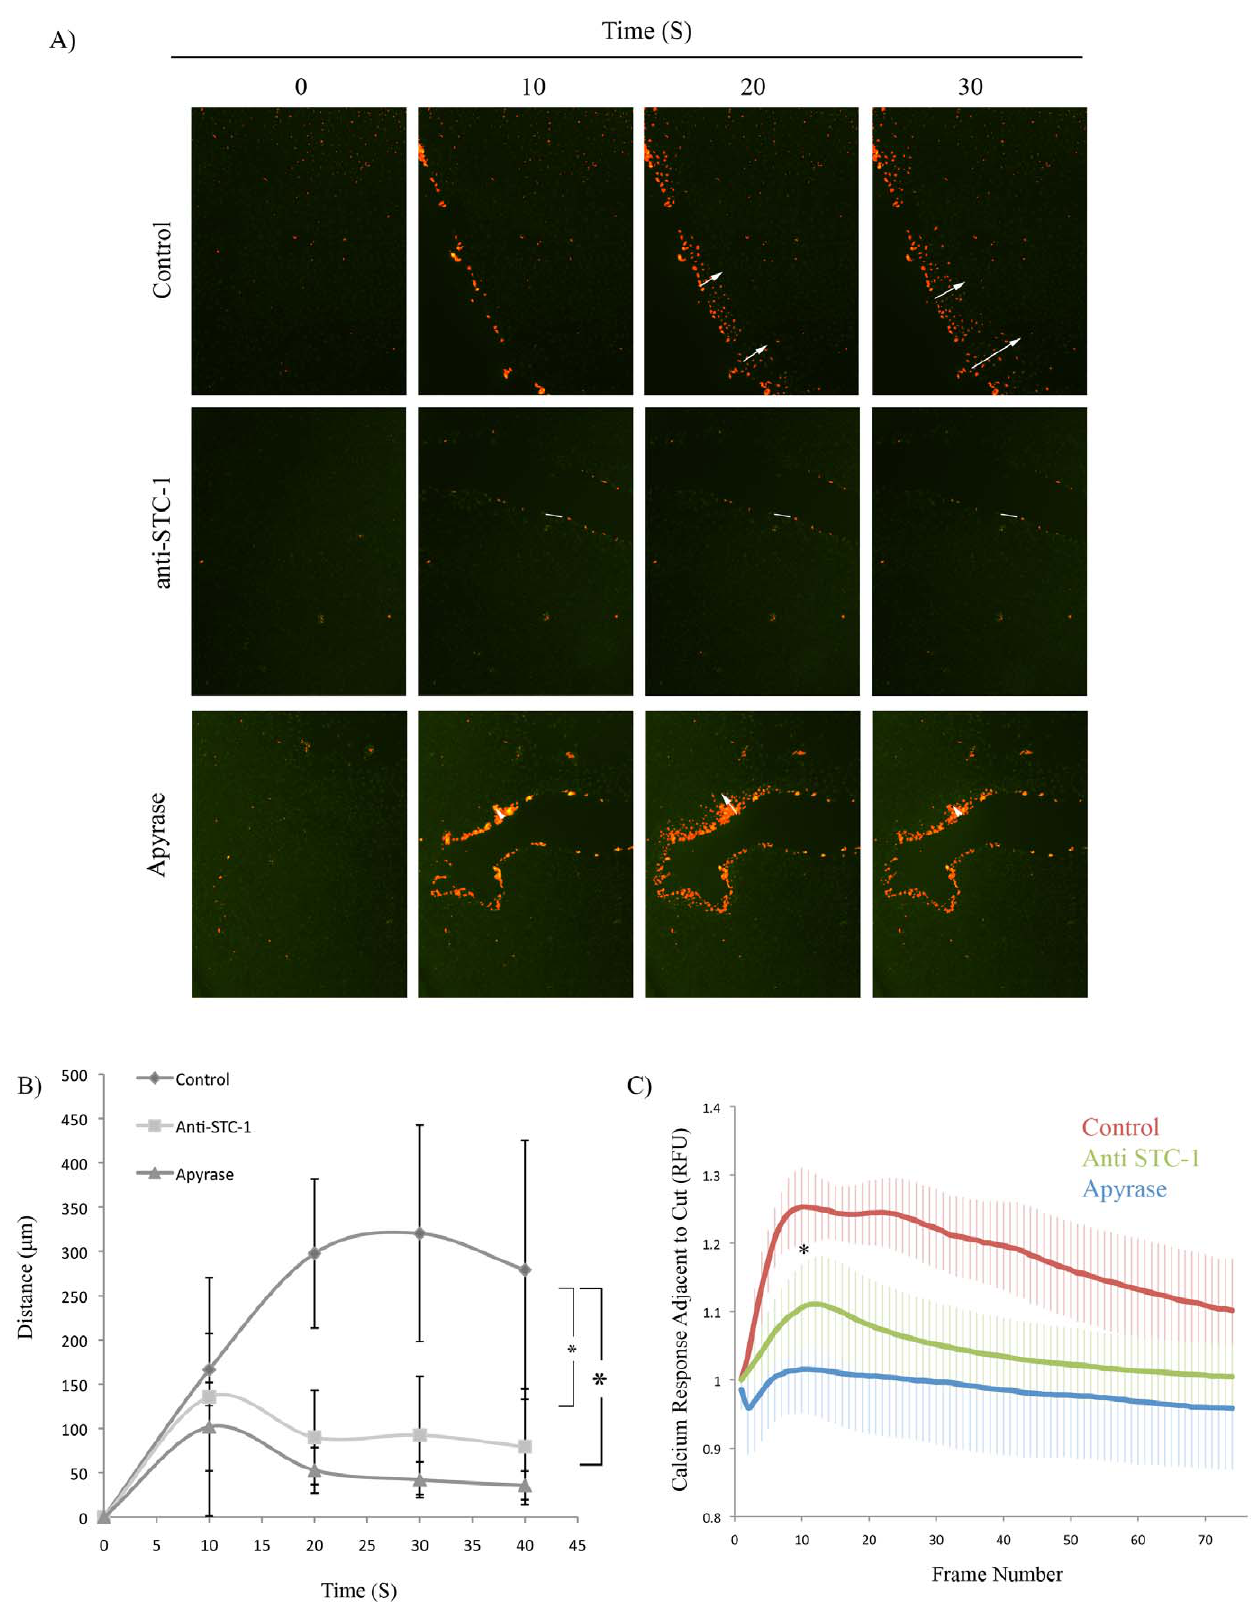
Figure 6. STC1 and Extracellular ATP Were Required for Calcium Wave Propagation following Mechanical Stimulation. A) Fluo-4 labeled A549 monolayers were mechanically stimulated in the presence of isotype antibody (control), an STC1 blocking antibody (anti-STC1; 1 m g/